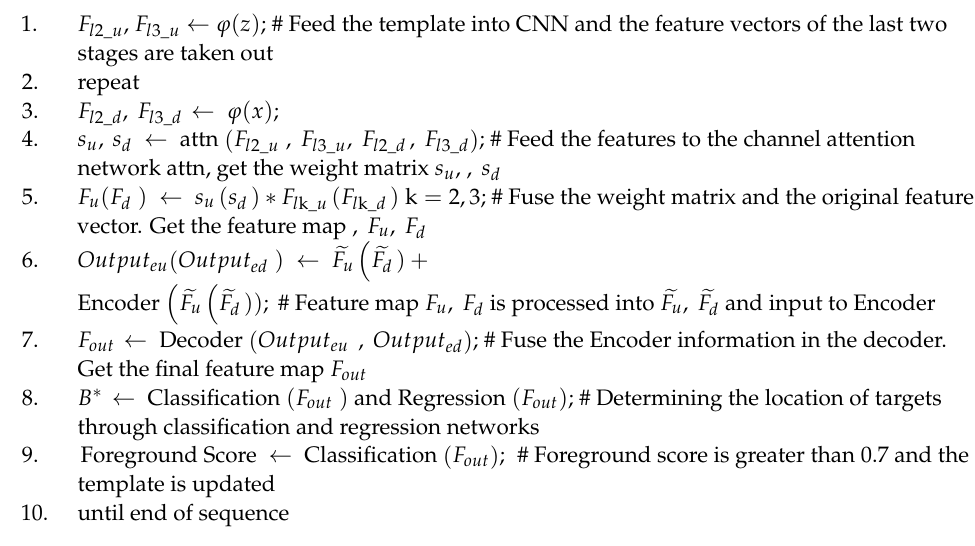
Algorithm 1 Procedure of the proposed